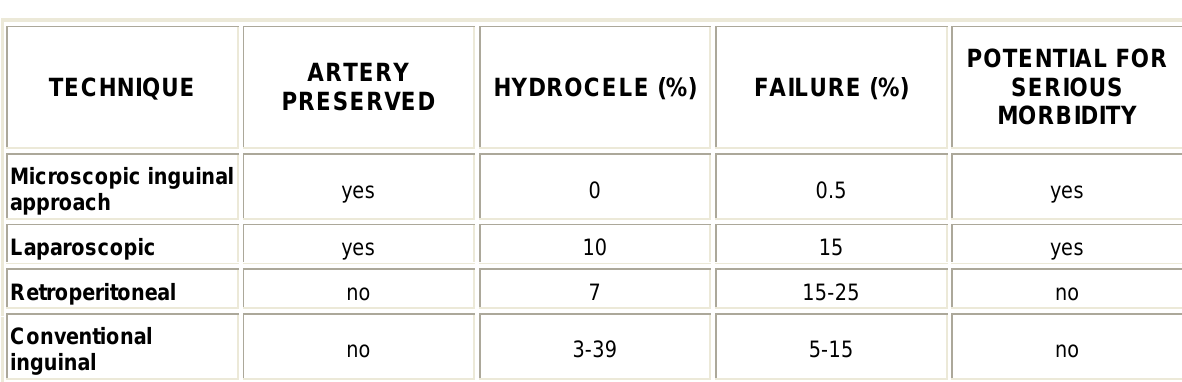
Techniques of Varicocelectomy